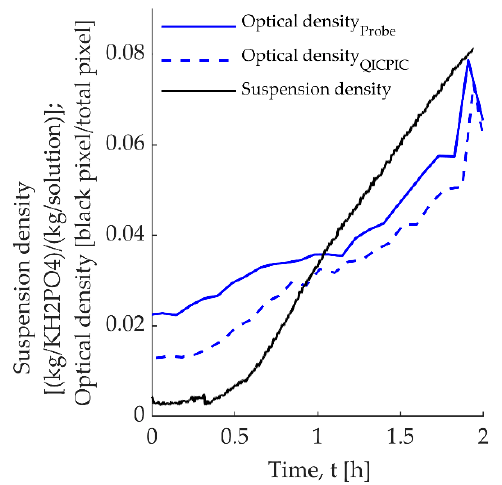
Figure 10. ATR-FTIR suspension density in comparison to the optical densities (microscope and probe) based on pixel ratios for Exp. 2—KH 2 PO 4 .